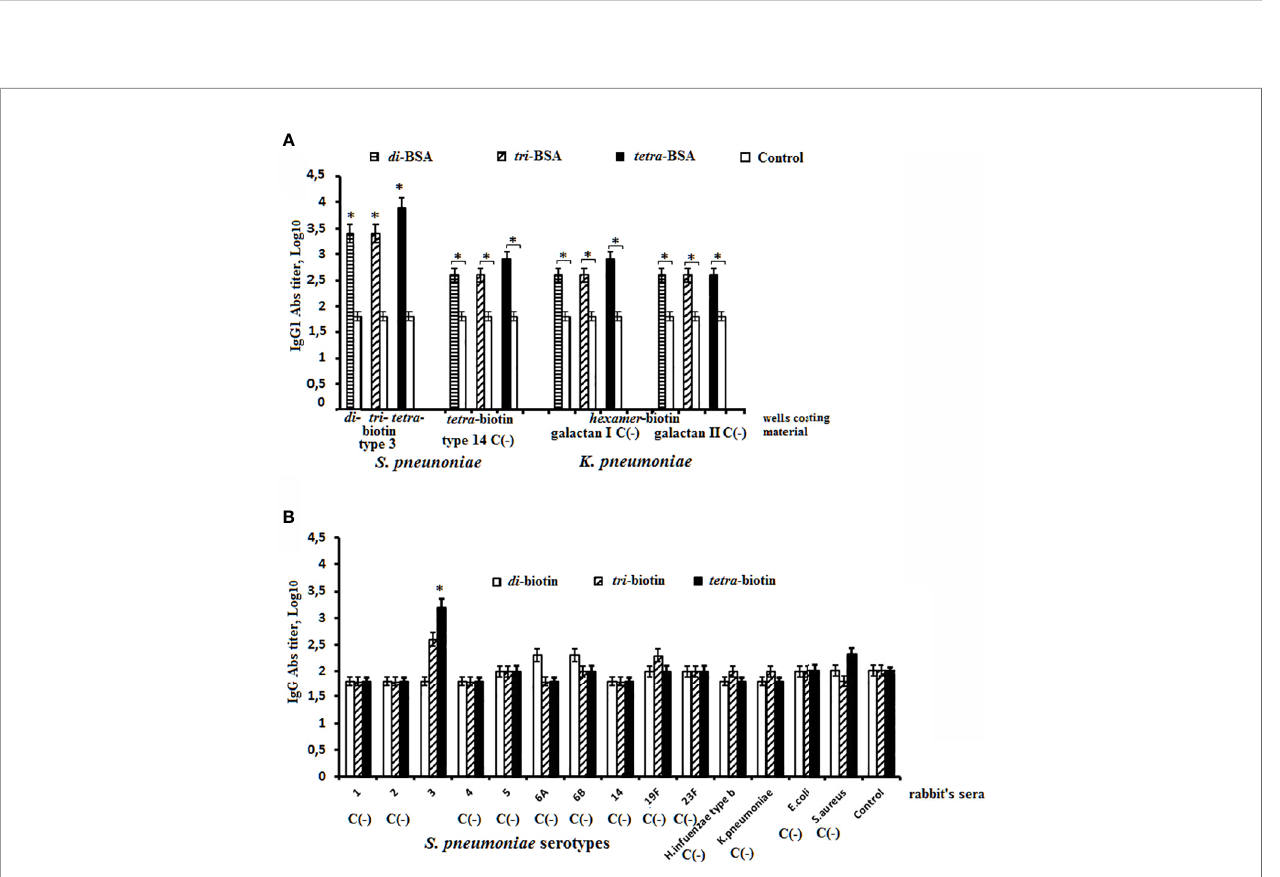
FIGURE 4 | Speci fi city of biotinylated OSs related to S. pneumoniae type 3 in ELISA. (A) Sera to S. pneumoniae type 3 di – , tri – , and tetra – BSA conjugates were obtained after prime-boost immunization of mice with glycoconjugates adjuvanted with aluminum hydroxide. Abs titers were determined against S. pneumoniae type 3 biotinylated di-, tri-, and tetrasaccharide. Biotinylated oligosaccharides related to CP of S.pneumoniae type 14 and K. pneumoniae immobilized on the surface of streptavidin pre-coated plates were used as the negative control C( − ). (B) The antibody titers against S. pneumoniae type 3 biotinylated di-, tri-, and tetrasaccharide were determined in sera to the unrelated serotypes of S. pneumoniae and some gram-negative and gram-positive bacteria. Antibody titers were transformed to log 10 (3 assays per antiserum). The sera obtained from non-immunized mice were used as the control. Data are displayed as a mean value ± SD. Mann – Whitney Rank Sum tests were used to determine signi fi cance, * P <